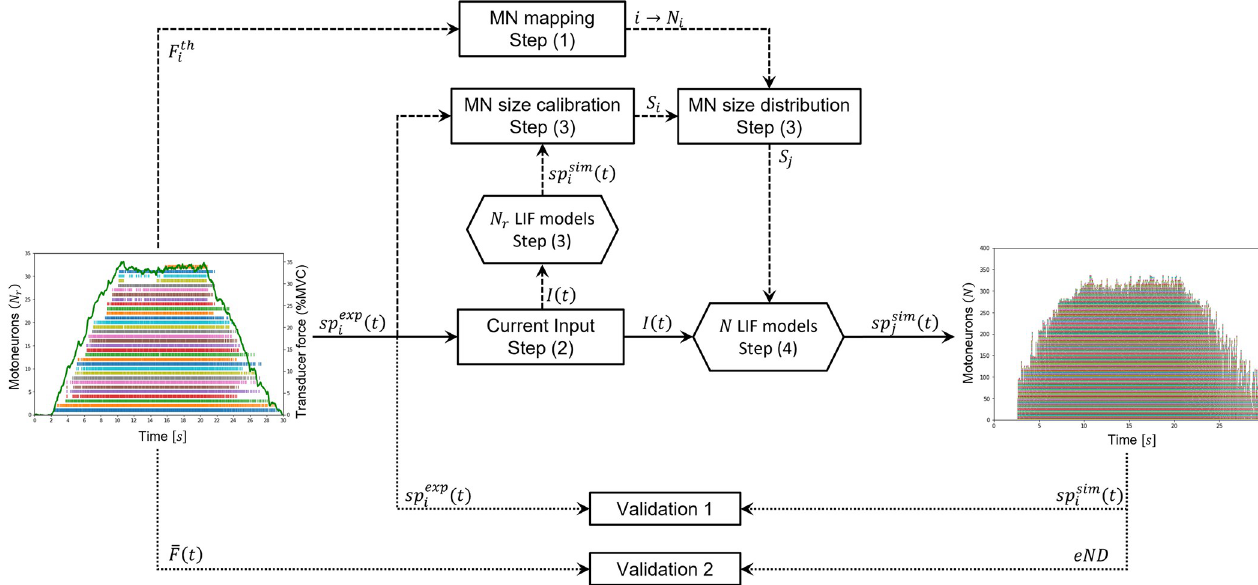
Fig 1. Four-step workflow predicting the spike trains sp sim ð t Þ of the entire pool of N MNs (right figure) from the experimental sample of N MN spike trains r j , each MN, ranked from i = 1 to i = N r following increasing recruitment sp exp i ð t Þ (left figure). Step (1): according to their experimental force thresholds F th i thresholds, was assigned the N th location in the complete pool of MNs ( i ! N i mapping). Step (2): the current input I ( t ) common to the MN pool was derived i spike trains sp exp ð t Þ . Step (3): using I ( t ) as input, the size parameter S of a cohort of N leaky-and-fire (LIF) MN models was calibrated by from the N r i r i minimizing the error between predicted and experimental filtered spike trains. From the calibrated S and the MN i ! N mapping, the distribution of MN sizes i i S j in the entire pool of virtual MNs was obtained by regression. Step (4): the S j distribution scaled a cohort of N LIF models which predicted the MN-specific spike trains sp sim ð t Þ of the entire pool of MNs (right). The approach was validated by comparing experimental and predicted spike trains (Validation 1) and by j comparing normalized experimental force trace F ð t Þ (Left figure, green trace) with normalized effective neural drive (Validation 2). In both figures, the MN spike trains are ordered from bottom to top in the order of increasing force recruitment thresholds.